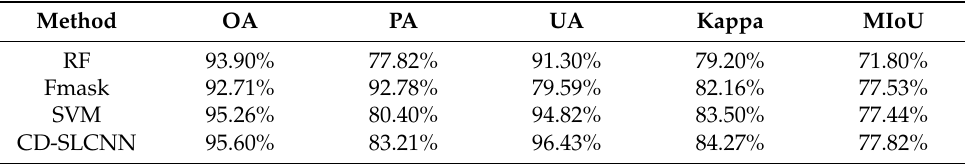
Table 1. Quantitative analysis of the CD-SLCNN results of Landsat-8 biome